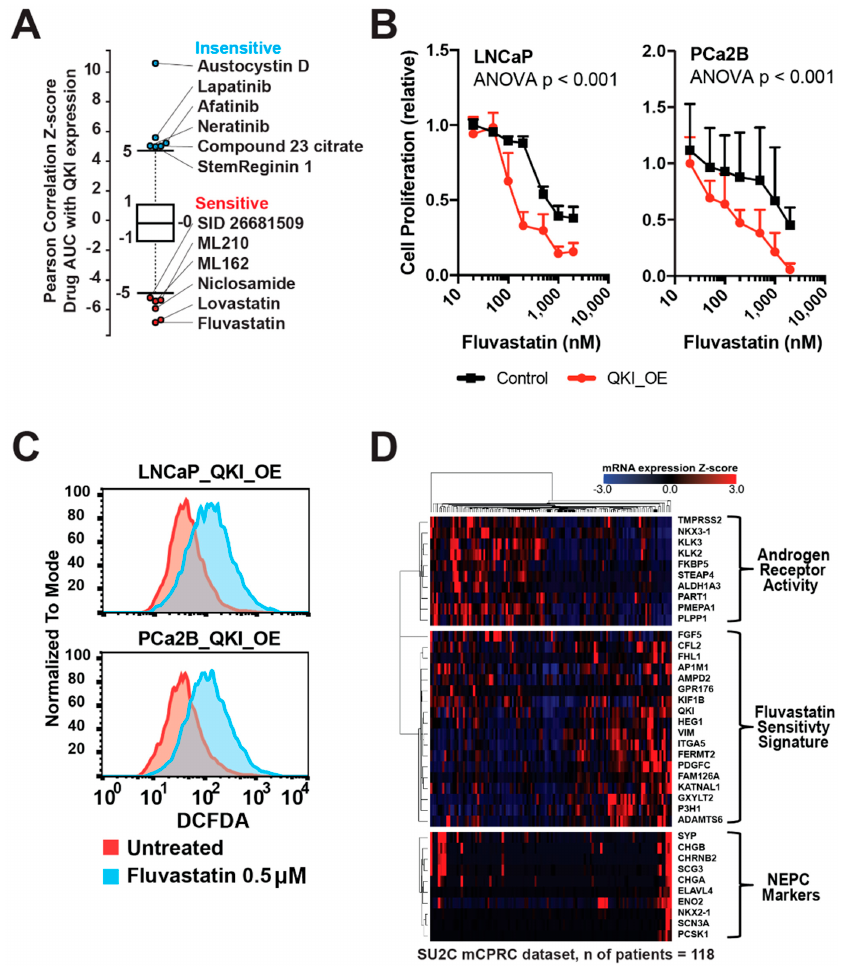
Figure 5. QKI-overexpressing CRPC cells are selectively sensitive to statins. ( A ) Correlation plot showing drug sensitivity (AUC) and QKI gene expression profile. Y-axis represents the correlation